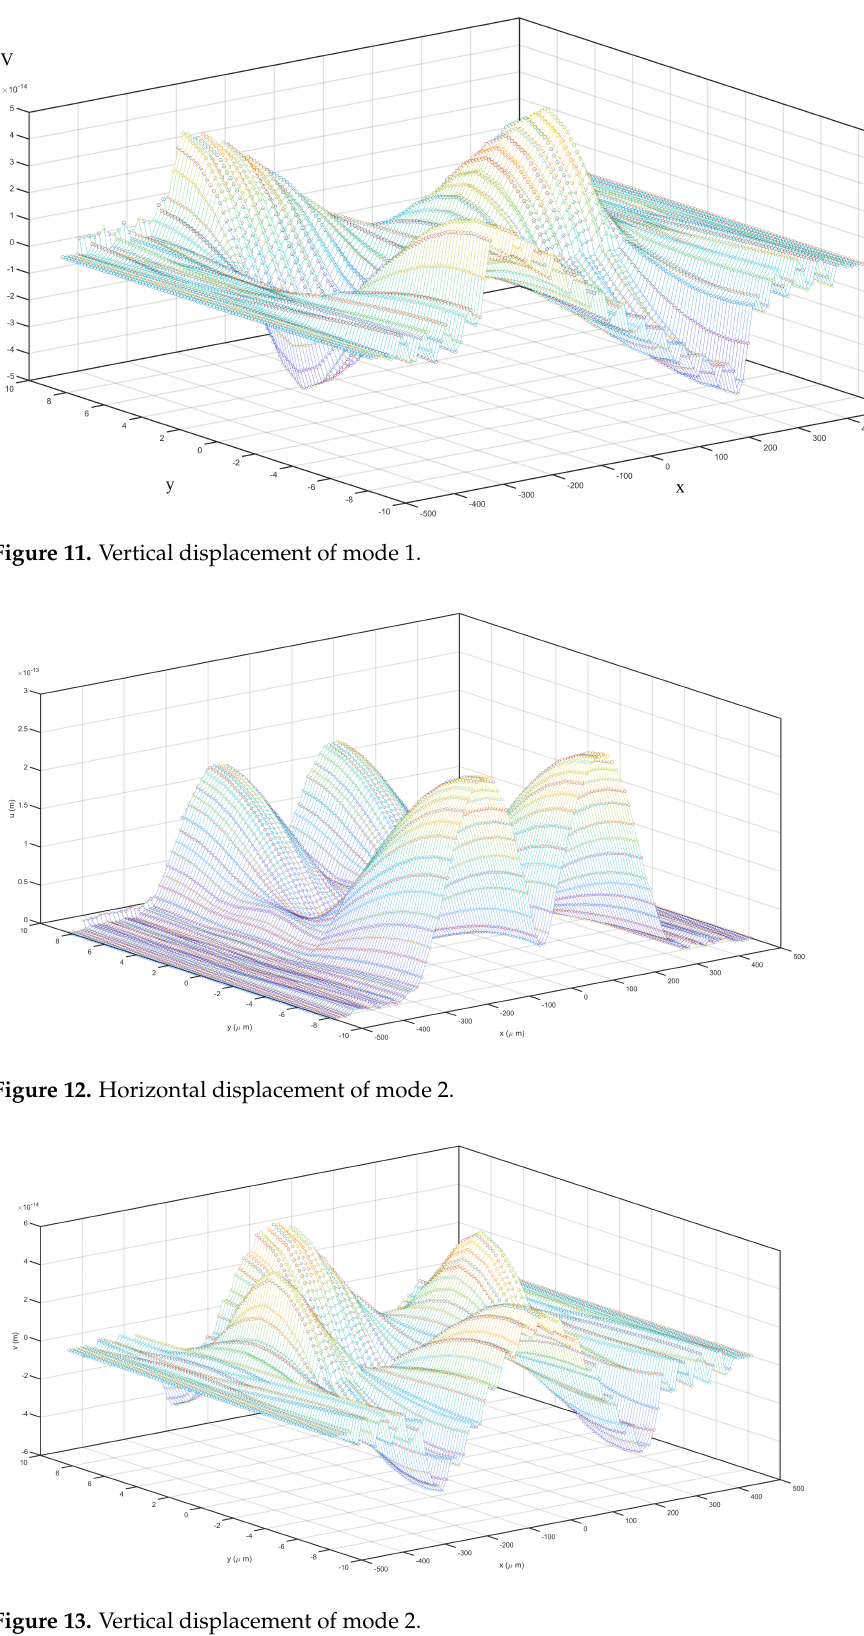
Figure 13. Vertical displacement of mode